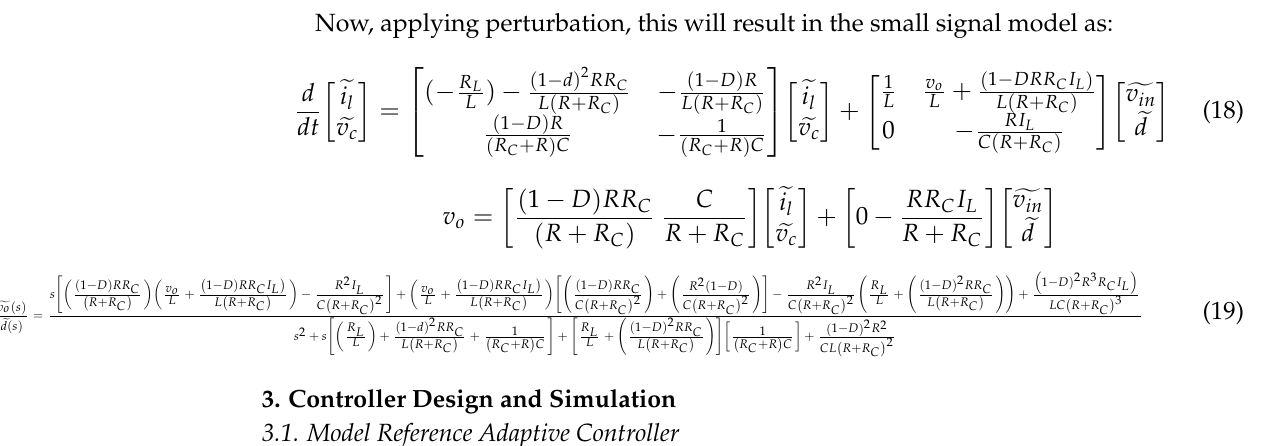
Figure 4. Direct model reference adaptive control system .